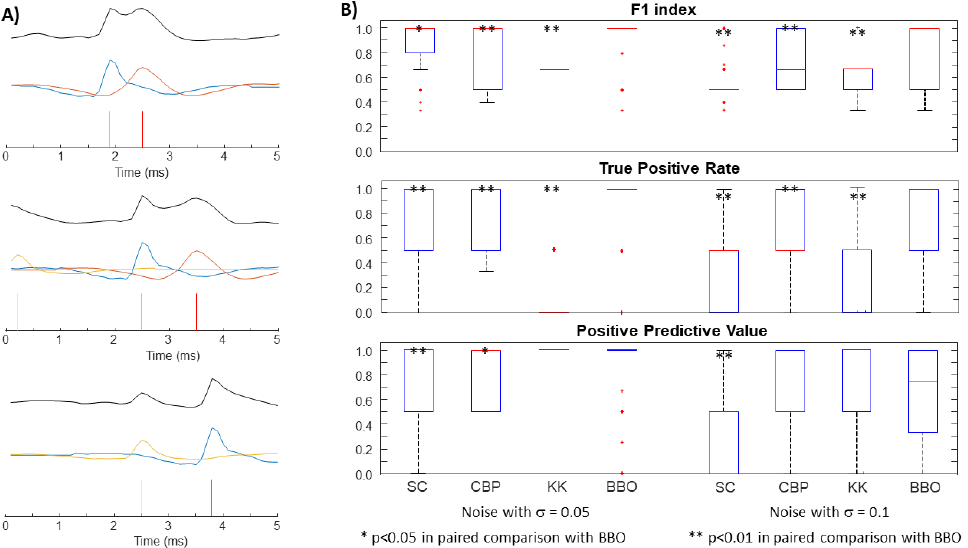
Figure 3. Overall results on the resolution of 100 overlaps randomly occurring in simulated data. ( A ) Few examples of overlap, with indication of the prototypes superimposed. ( B ) F1 Index, True Positive Rate (TPR) and Positive Predictive Value (PPV) are shown in box and whiskers plots. The performances of SpyKING Circus (SC), Continuous Basis Pursuit (CBP), KlustaKwik (KK) and Biogeography-Based Optimization (BBO) are shown for two levels of noise. Paired comparisons between one of the three reference methods (SC, CBP and KK) and BBO, providing statistically significant differences, are indicated.